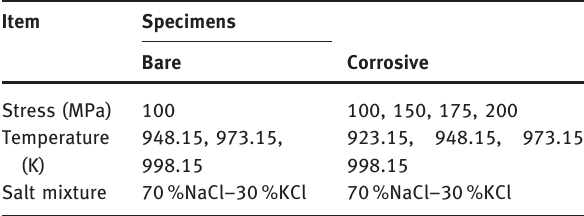
Table 2: Compression creep test matrix of the 12Cr1MoV alloy.